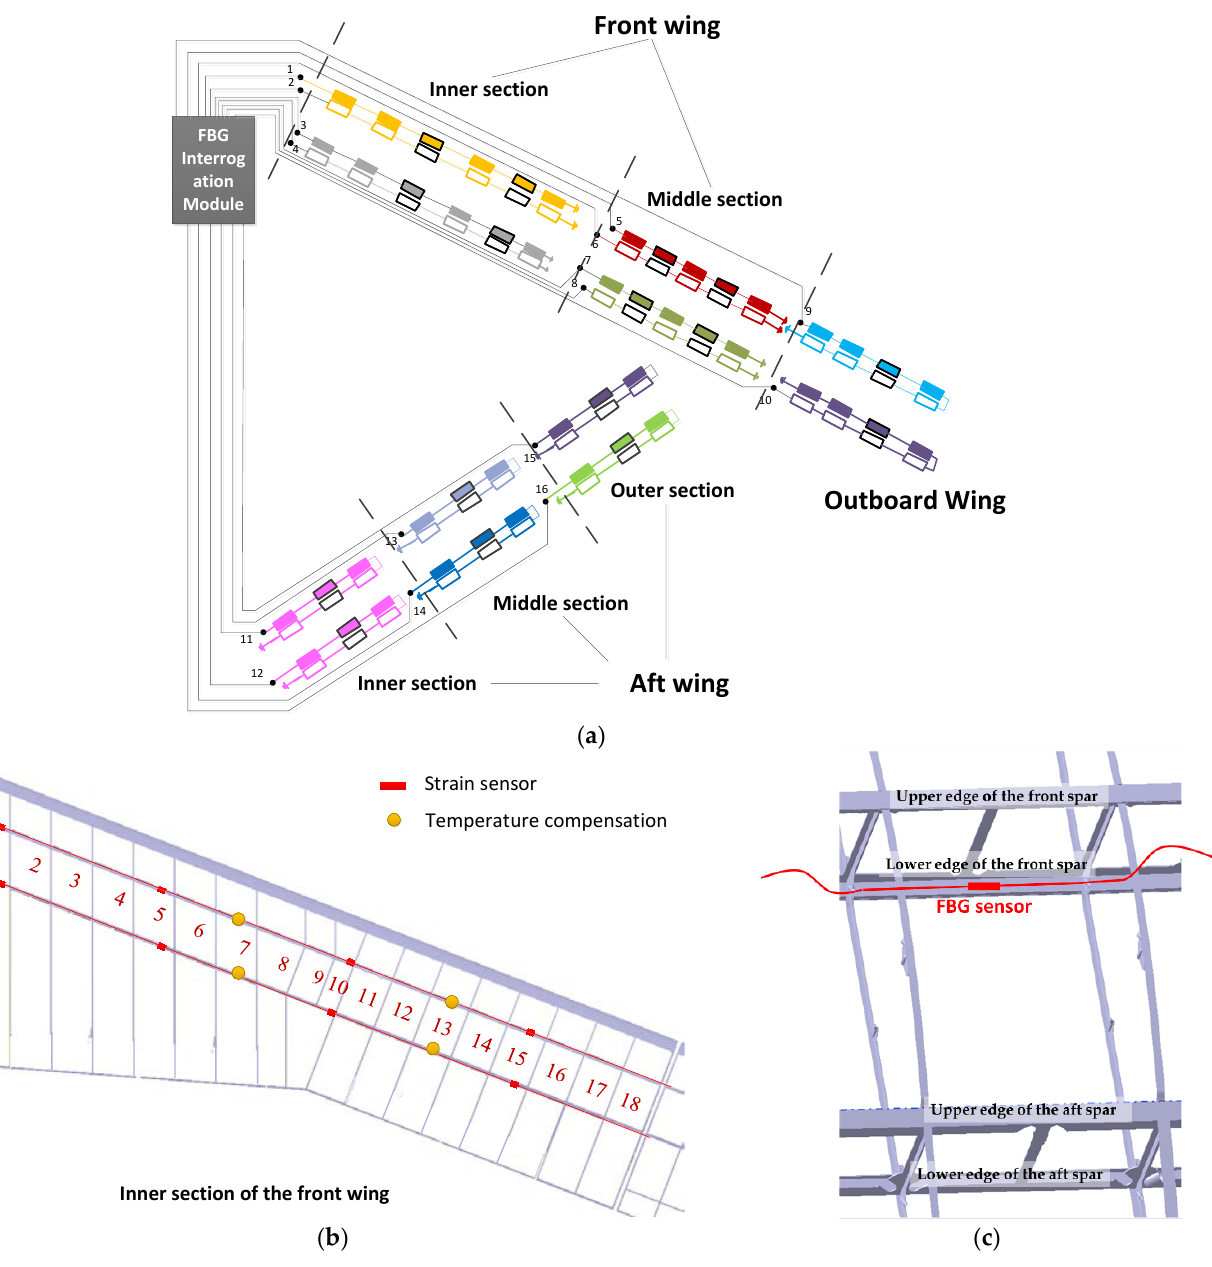
Figure 4. Sensor layout. ( a ) The overall sensor arrangement of the half model; ( b ) sensor arrangement of the inner section of the front wing; ( c ) detail view of FBG sensor installation on the surface of the spar. Figure 5 is a snapshot of the wing interior. Both the electric cables and the optical fibers are bundled with the skeleton inside the wing. The FBG sensors are attached to the spar surfaces using epoxy adhesive. The temperature compensation is realized by the FBG sensor in a tube with a rigid steel needle